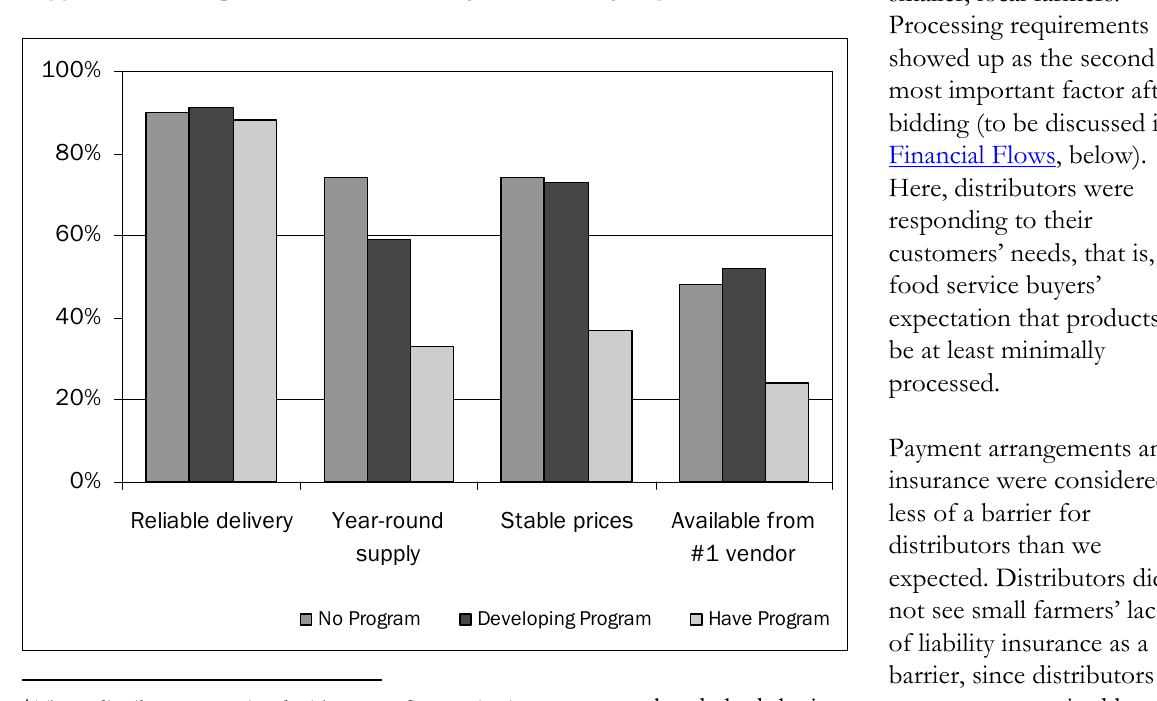
Figure 3. Food Service Buyers’ Rating of Various Criteria for Local Produce Suppliers: % Rating Each Criterion as Very or Extremely